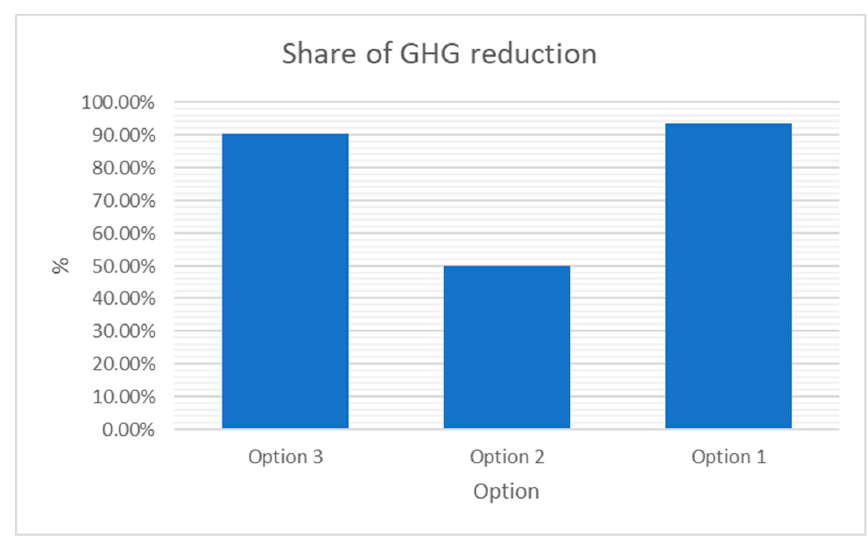
Figure 7. Share of GHG reduction, in comparison with Option 4.